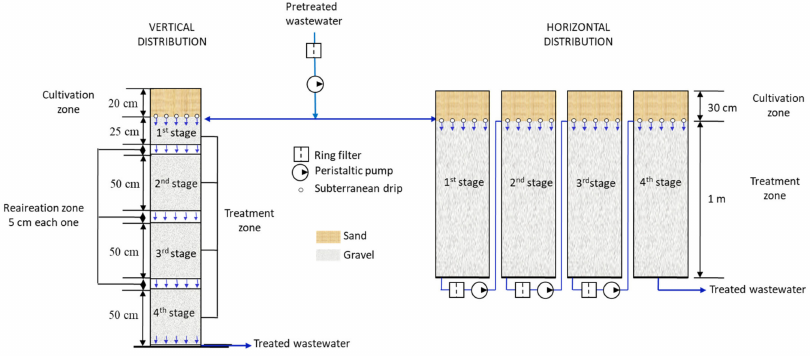
Figure 2. Layout of the pilot plants.